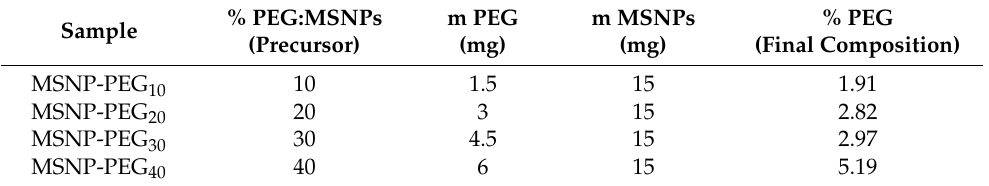
Table 1. Optimization of the PEGylation process of MSNPs calculated with termogravimetric analyses.